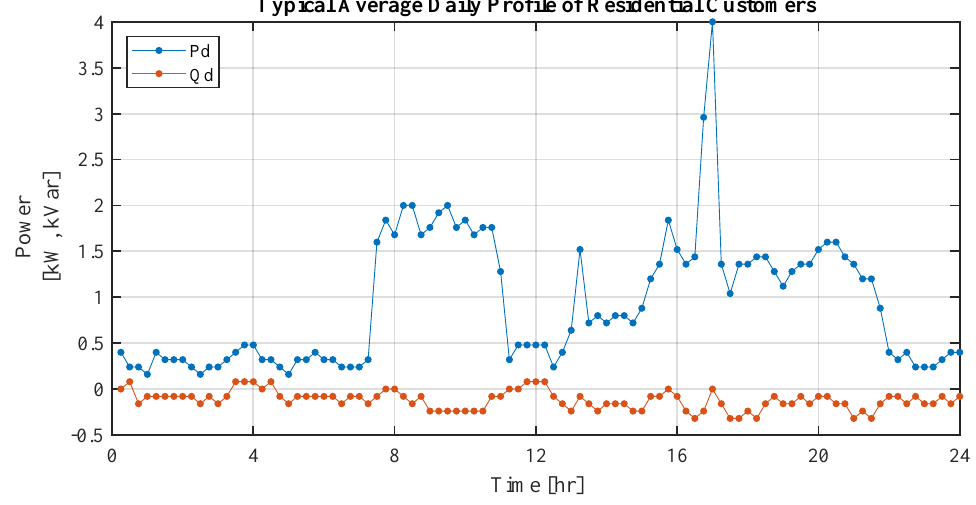
Figure 9. Plot of standard power profiles of residential customers on a typical day.